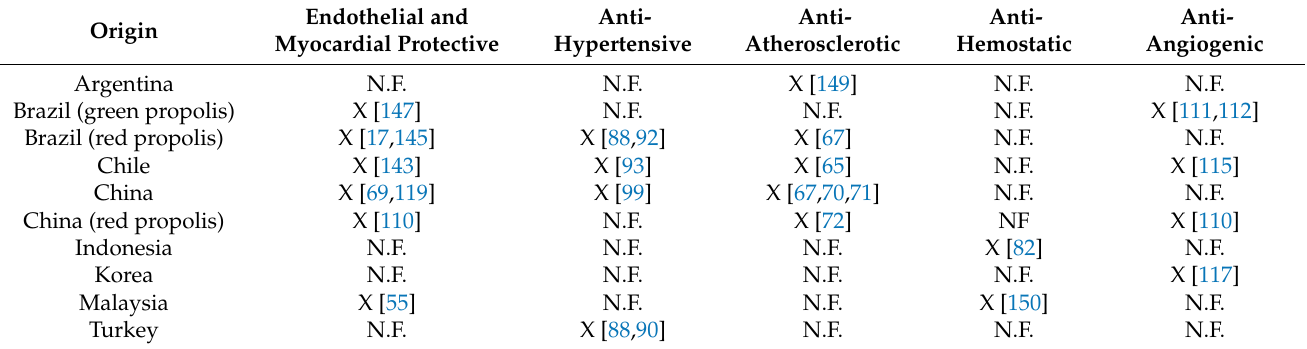
Table 6. Propolis activities according to their geographical origin (N.F.—not found and X—scientifically proven activity).